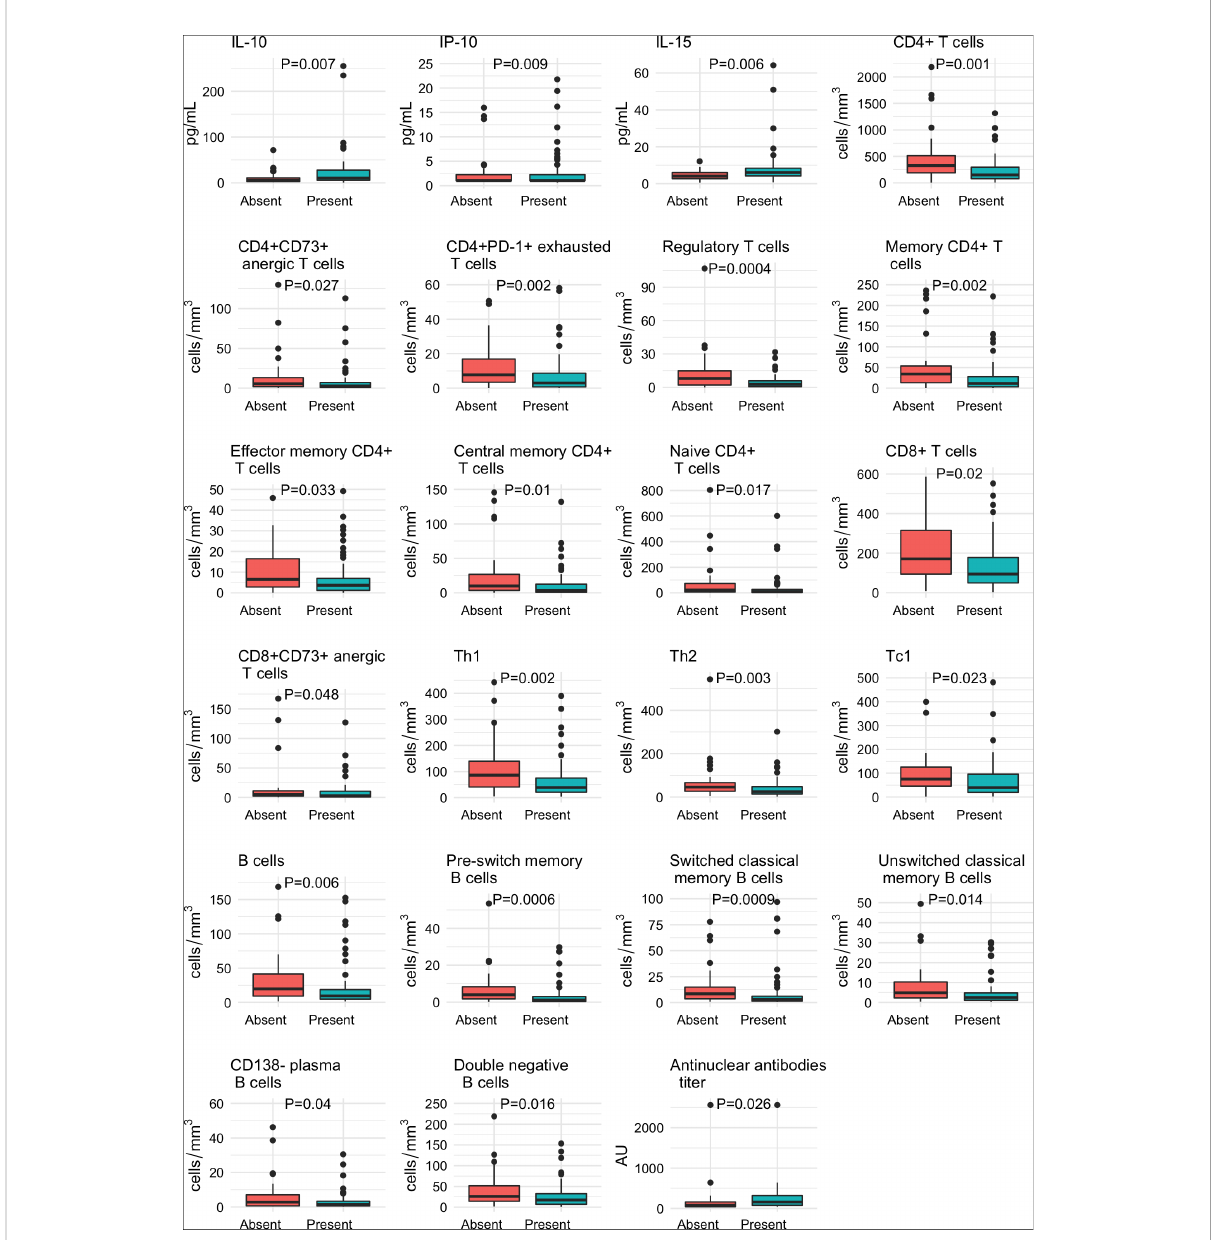
FIGURE 2 Baseline differences in the immunological pro fi le of patients with COVID-19 according to the development of a sustained immune humoral response. The absolute numbers of T and B cell subsets, the cytokines, chemokines and AC/ANA titers are expressed as medians and interquartile ranges and were compared with the Wilcoxon